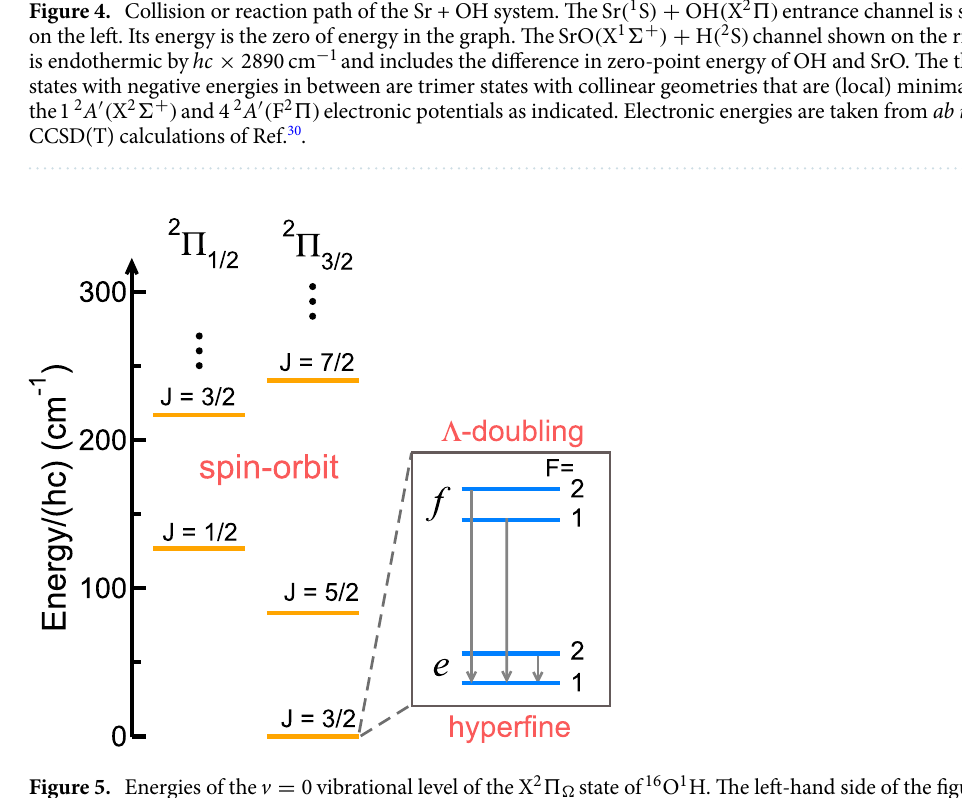
1 and 2) of the energetically-lowest =